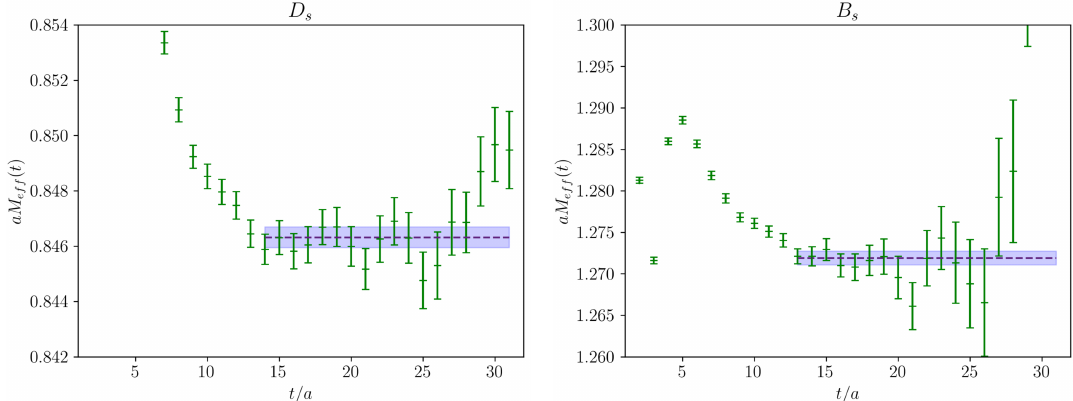
Figure 5 . Effective mass aM eff ( t ) ≡ log ( C ( t ) /C ( t + a )) in lattice units for the D s -meson (left panel) and the B s -meson (right panel) correlation function (2.21), evaluated using the ETMC gauge ensemble B55.32 for bare quark masses equal to aµ b = 0 . 50 , aµ c = 0 . 25 and aµ s = 0 . 021